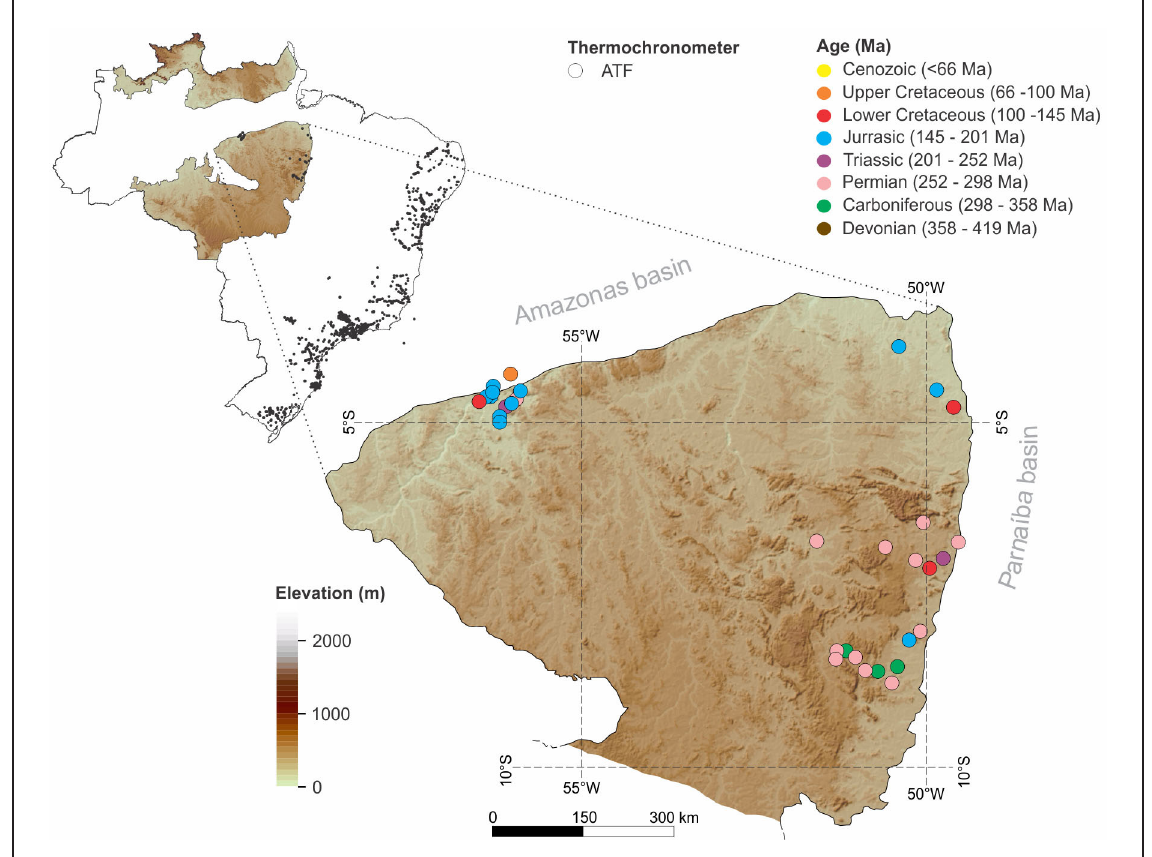
FIGURE 4 . Thermochronological data set published in the Amazonian